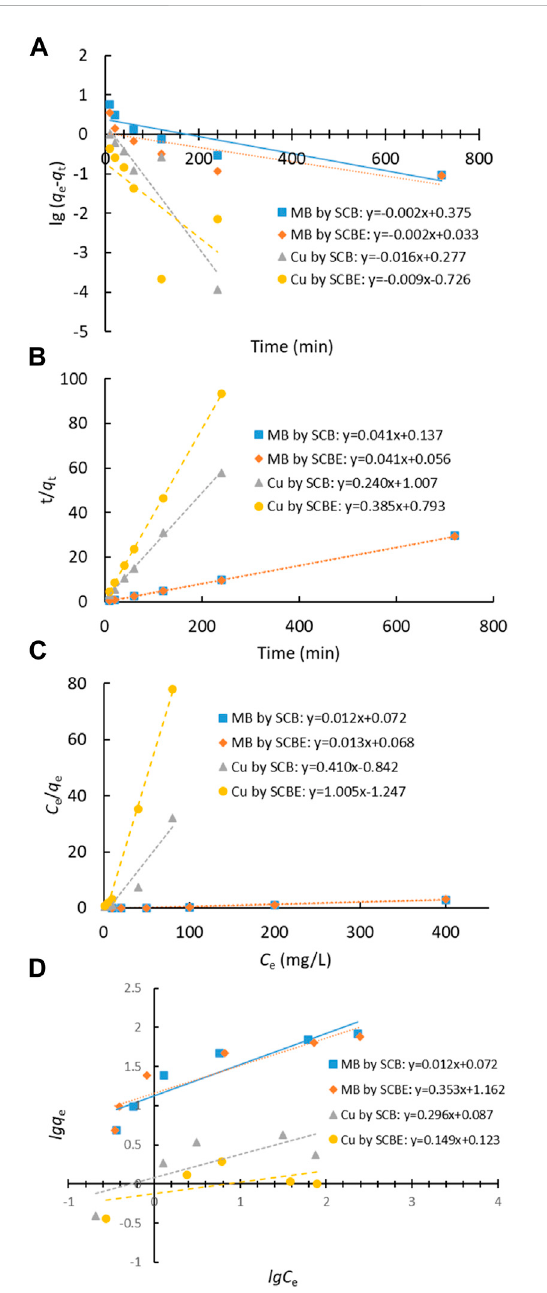
FIGURE 6 Adsorption models of dye MB and Cu 2+ by SCB or SCBE: